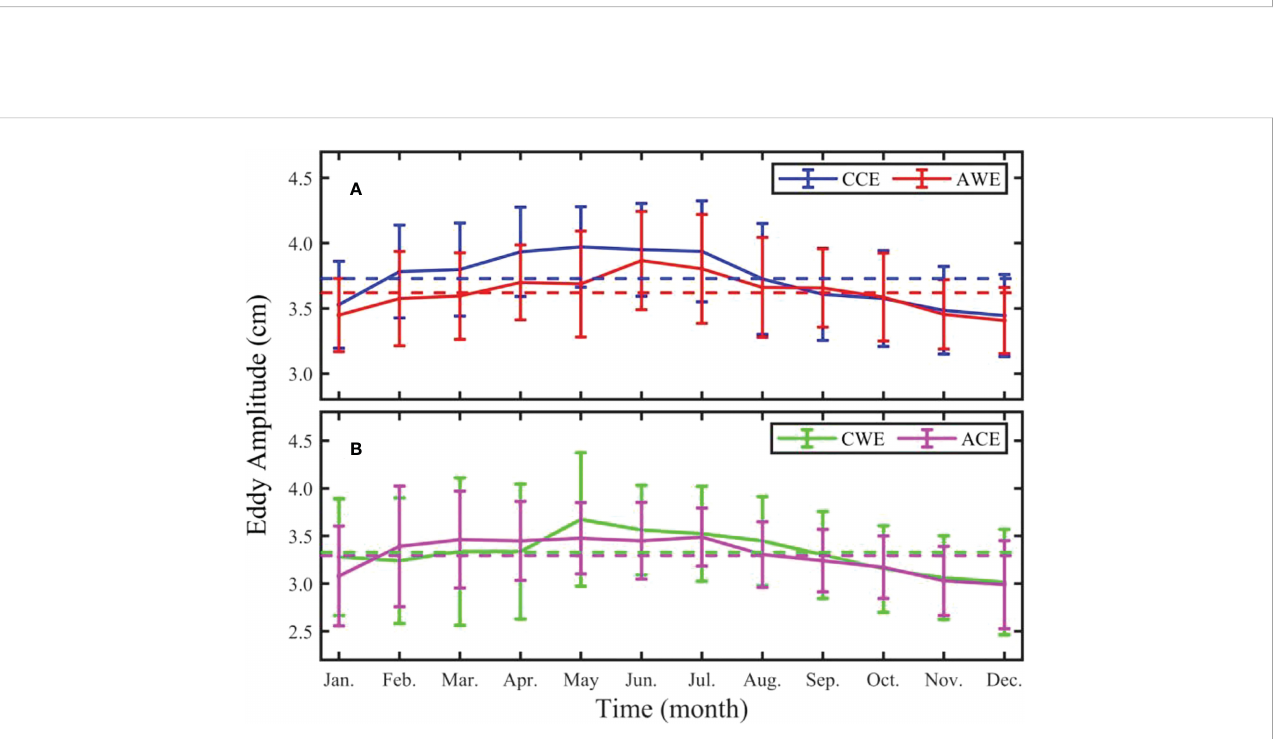
FIGURE 6 Monthly distribution of multi-year (2008 ~ 2017) average eddy amplitude at the sea surface (A, B) in the STCC area. Blue, red, pink, and green curves represent cyclonic cold-core eddy, anticyclonic warm-core eddy, cyclonic warm-core eddy, and anticyclonic cold-core eddy, respectively. The vertical line represents the standard deviation, and the dotted line represents the multi-year average value.